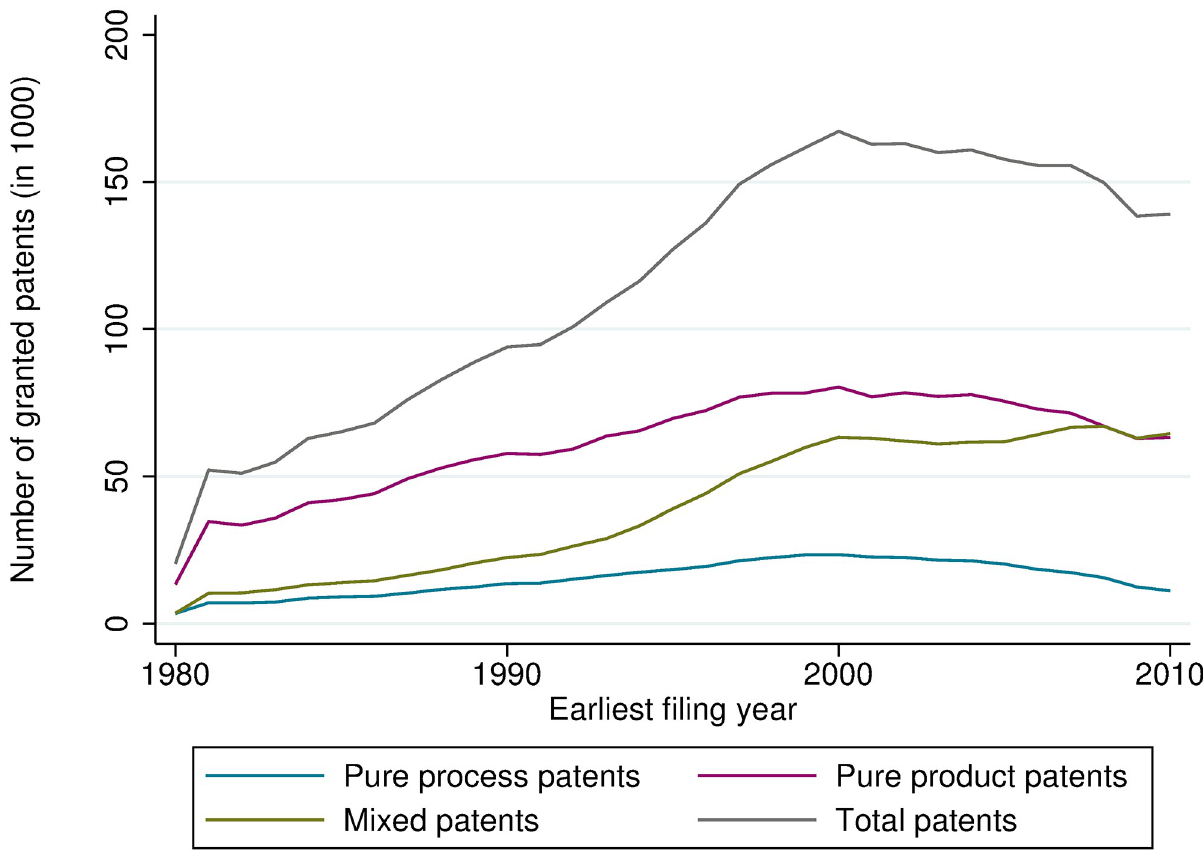
Fig 2. Count of product, process, and mixed patents, granted at the